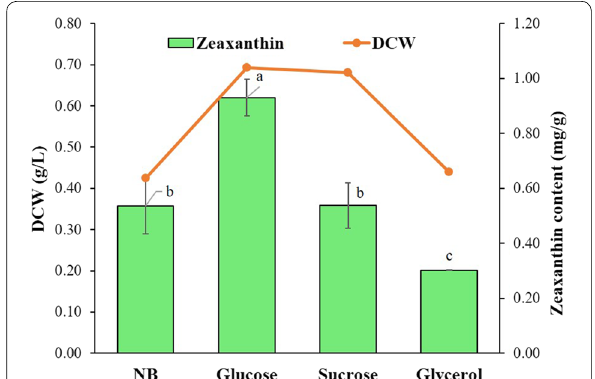
Fig. 8 Effect of different carbon source as co-substrate for zeaxanthin accumulation by A. gandavensis MTCC 25325 after 72 h. All statistical significance comparisons between indicated groups were performed using a one-way ANOVA with Fisher’s post-test. Data presented are mean values and their standard